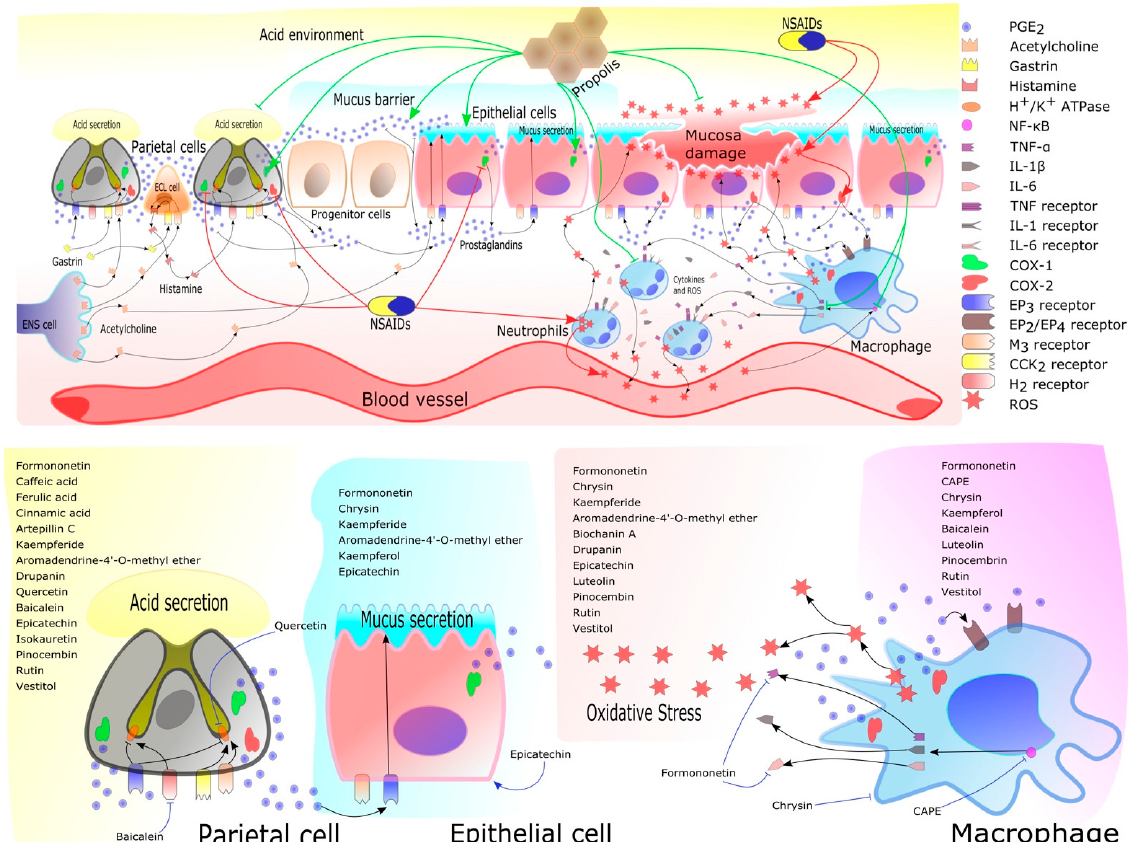
Figure 2. Physiological regulation of gastric mucosa and key factors involved in the gastroprotective effect of propolis against NSAIDs-induced gastric ulcers. Black arrows and slashes show the relationship between the cells that are present in gastric mucosa. The ganglion cell of the enteric nervous system (ENS) that secretes histamine interacts with parietal cells and epithelial cells to regulate the acid and mucus secretion, respectively; additionally, it induces the secretion of histamine in the enterochromaffin-like cells (ECL), and, together with the gastrin, induces acid secretion in parietal cells. COX isoenzymes (COX-1 and COX-2) and their localization in the gastric mucosa cells are presented, as well as the production of prostaglandin E 2 (PGE 2 ), which is a key molecule that regulates mucus production in epithelial cells and acid suppression in parietal cells; moreover, it is implicated in the pro-inflammatory response exerted by leucocytes as a response to the increase in the prostaglandin secretion by COX-2, as well as the reduction in blood flow in the gastric mucosa. The COX suppressor activity of NSAIDs and their adverse effects in the gastric mucosa cells, such as the capacity for generating COX-independent damage in epithelial cells by inducing reactive oxygen species (ROS) production, are shown by red arrows and slashes. On the other hand, green arrows and slashes show the key factors implicated in the gastroprotection of propolis in the gastric mucosa, as well as its antioxidant and anti-inflammatory effects in the gastric tissue. Finally, membrane receptors and their agonists are included in the figure according to their cellular localization and physiological function in the gastric mucosa. Additionally, are shown some secondary metabolites identified in propolis samples that display gastroprotective effects and the cell types in which they have their activity. In the yellow section are named secondary metabolites that have antacid activities; the blue section is listed secondary metabolites that stimulate gastric mucus secretion; the red section is shown secondary metabolites that own antioxidant activity, and the purple section is shown secondary metabolites that displays anti-inflammatory activities related to gastric ulcer disease. It should be noted that the blue arrows and slashes are shown specific activity of some secondary metabolites as the baicalein that display their suppressive activity of acid secretion in parietal cells by means of H2 receptors. Quercetin inhibits the proton pump ATPase activity of parietal cells. On the other hand, epicatechin has cytoprotective activity in epithelial cells of the gastric mucosa; and formononetin (an inhibitor of TNF- α and IL-6), chrysin (that is an immunomodulator), and CAPE (an inhibitor of NF- κ B) display their activities on leukocytes of gastric mucosa in the ulcerative process.